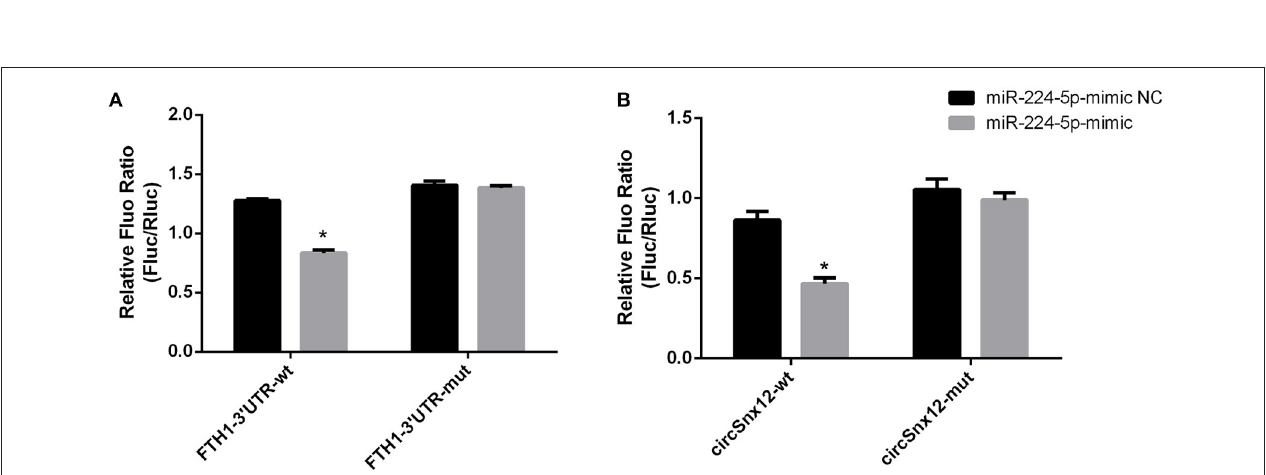
FIGURE 7 | Dual-luciferase reporter activities. The interrelationships of miR-224-5p with FTH1 (A) and circSnx12 (B) were confirmed using dual-luciferase reporter assays. * P < 0.05.